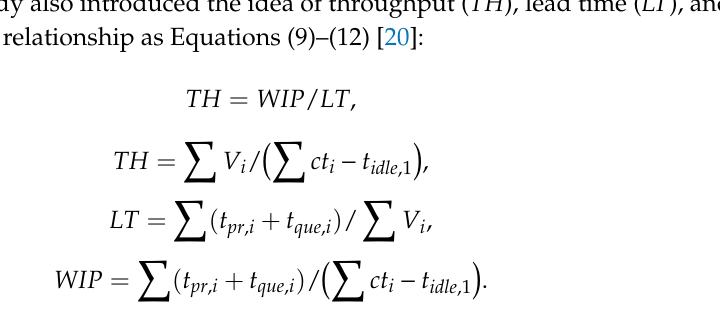
simulation which does not occur idling and queuing Figure 1. Flowchart of a daily chipping simulation. The flow in bold arrow is the flow in deterministic